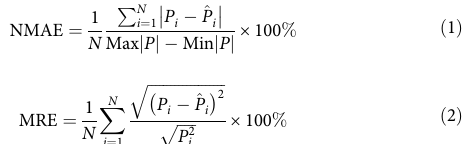
Table 4 Comparison of MRE from original PointNet and our network.